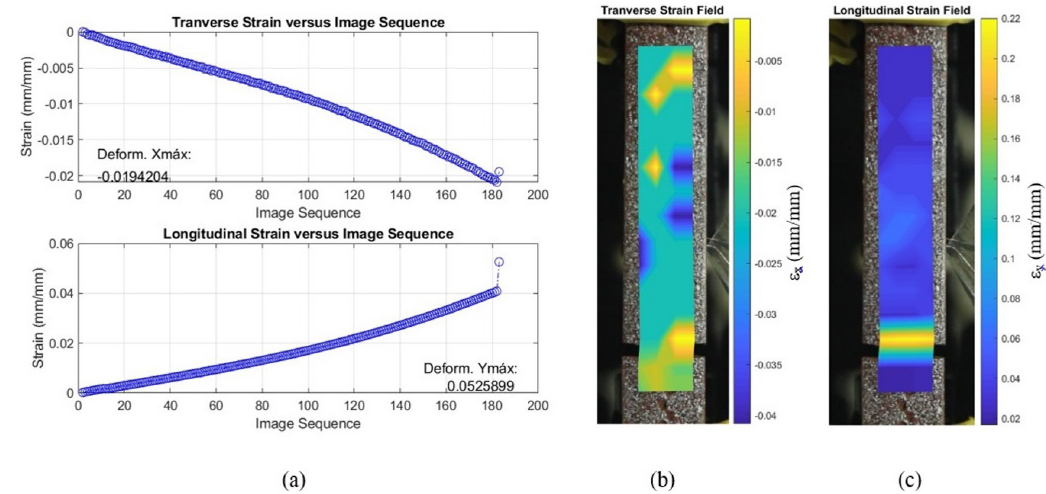
Figure 9. Deformations obtained by means of digital image correlation for sample CP02LV20 with a 30 x 5 rectangular grid. (a) Average deformations in the transverse and longitudinal directions. (b) Transverse deformation fields. (c) Longitudinal deformation fields.